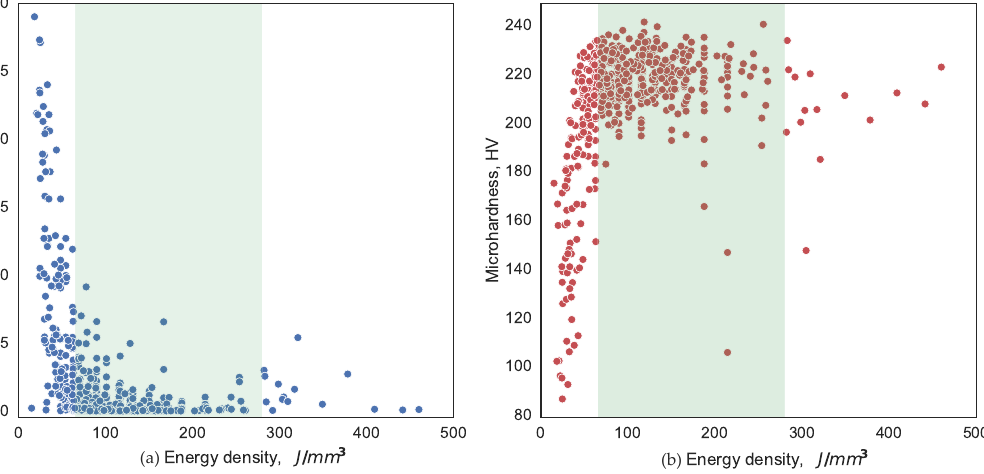
Figure 4. The scatter plot of ( a ) porosity (%) and ( b ) hardness (HV) as a function of VED. The shaded area represents the recommended operating window of 65–280 J/mm 3 .